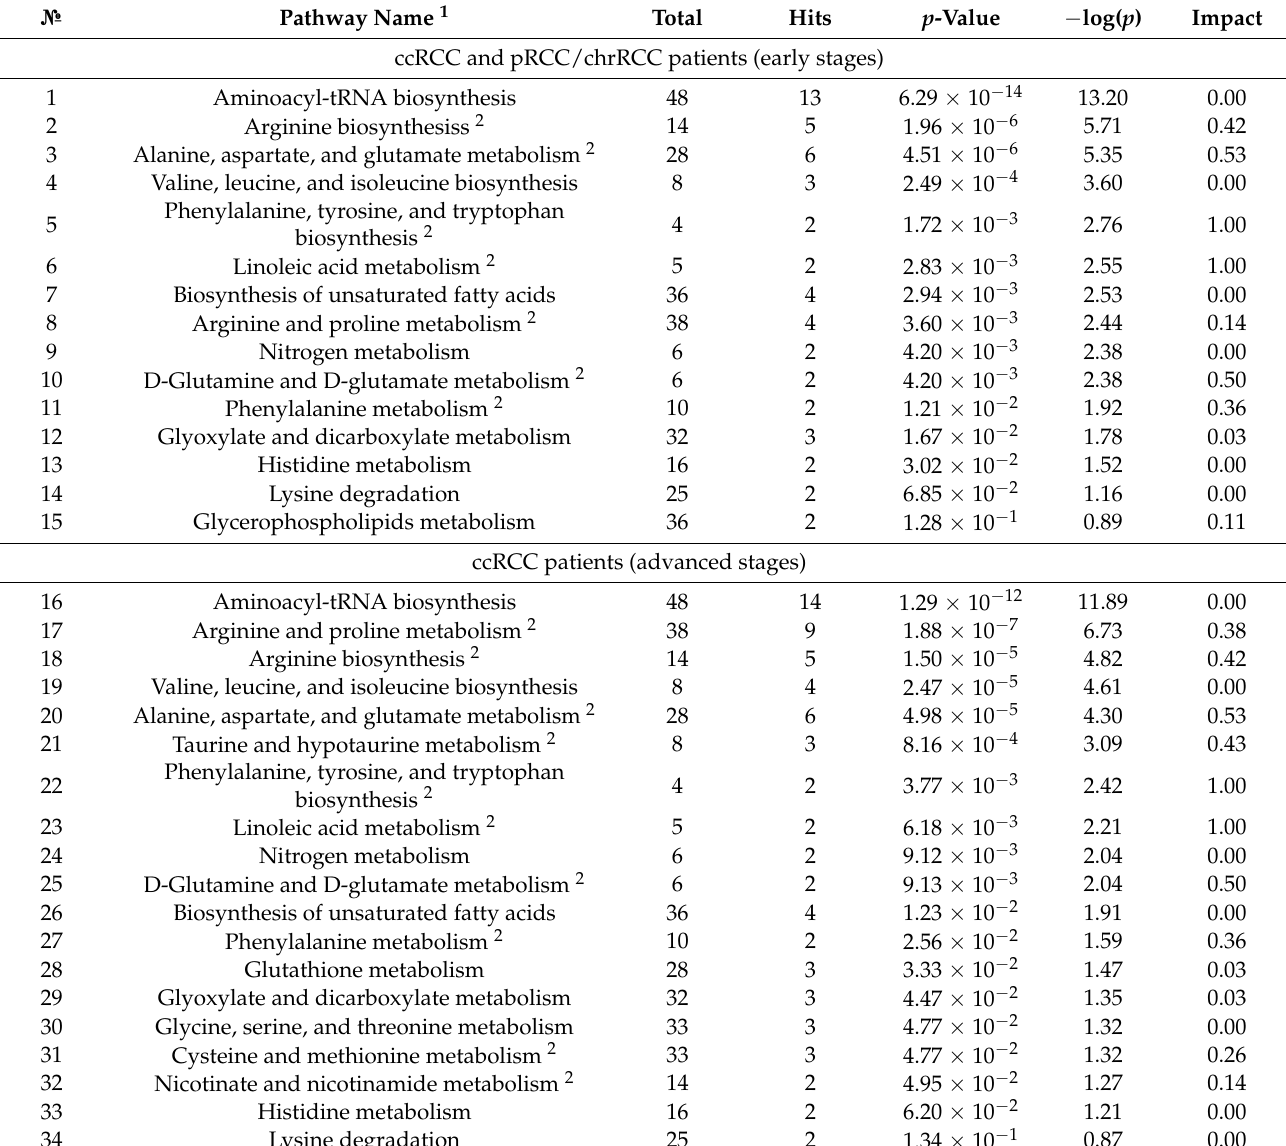
Table 3. Metabolic pathways altered at